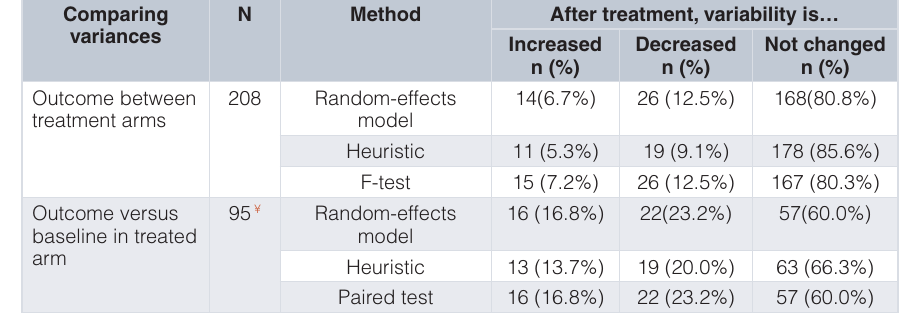
Table 1. Variance comparison. Alternative possible methods for estimating the number and percentage of studies with different variances on comparisons between arms and over-time. Limits for declaring different variances come from different statistical methods: (1) the analysis relying on random-effects model and funnel plots; (2) the heuristic analysis based on number of studies that have to be deleted from the random-effects model in order to achieve a negligible heterogeneity (studies with larger discrepancies in variances were removed one by one until the estimated value of τ was as close as possible to that of the reference model – the one that compares the variances of the response at baseline. See Methods for details); (3) classic statistical tests for comparing variances (F for independent outcomes or Sachs’ test 21 for related samples). ¥ This comparison was performed on studies reporting enough information to obtain the variability of the change from baseline to outcome, for example because they provide the correlation between outcome and baseline